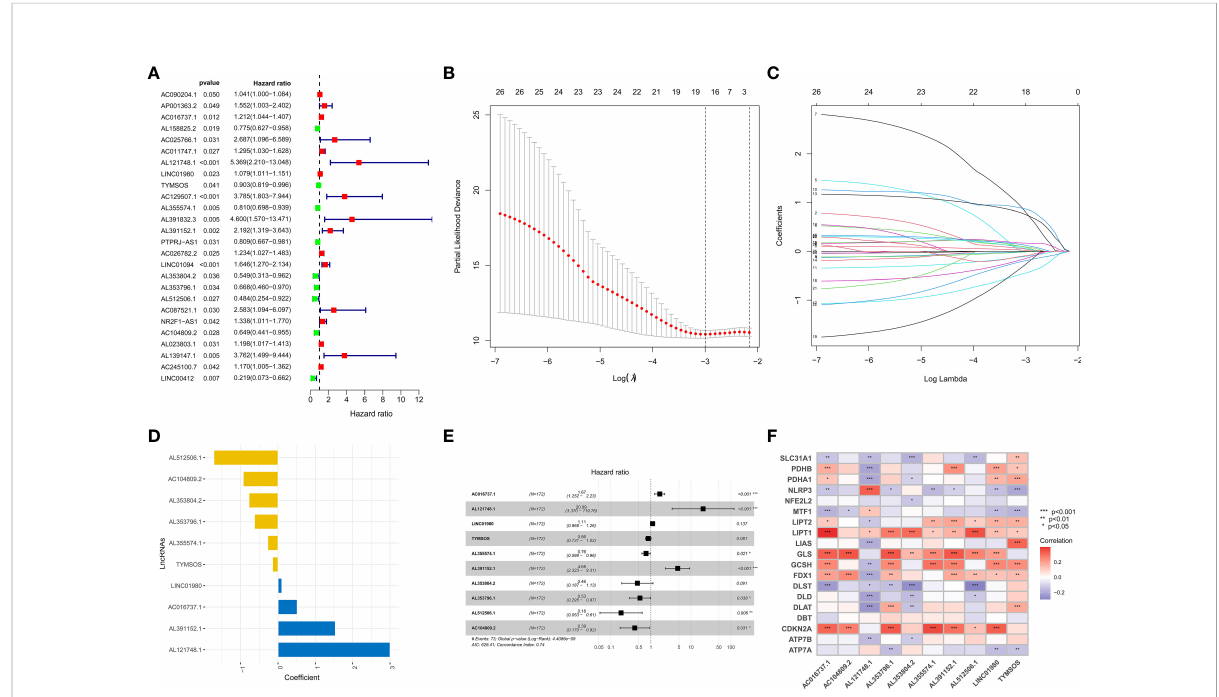
FIGURE 2 Establishment of the risk model. (A) Forest plot of 26 prognosis-related lncRNAs after univariate Cox regression analysis (p < 0.05). (B, C) LASSO regression of 26 prognosis-related lncRNAs. (D, E) The HR and coef fi cient of 10 CRLs involved in the multivariate Cox proportional hazards model. (F) The correlation between 19 CRGs and 10 CRLs in the risk model was visualized. *p < 0.05, **p < 0.01, and ***p <